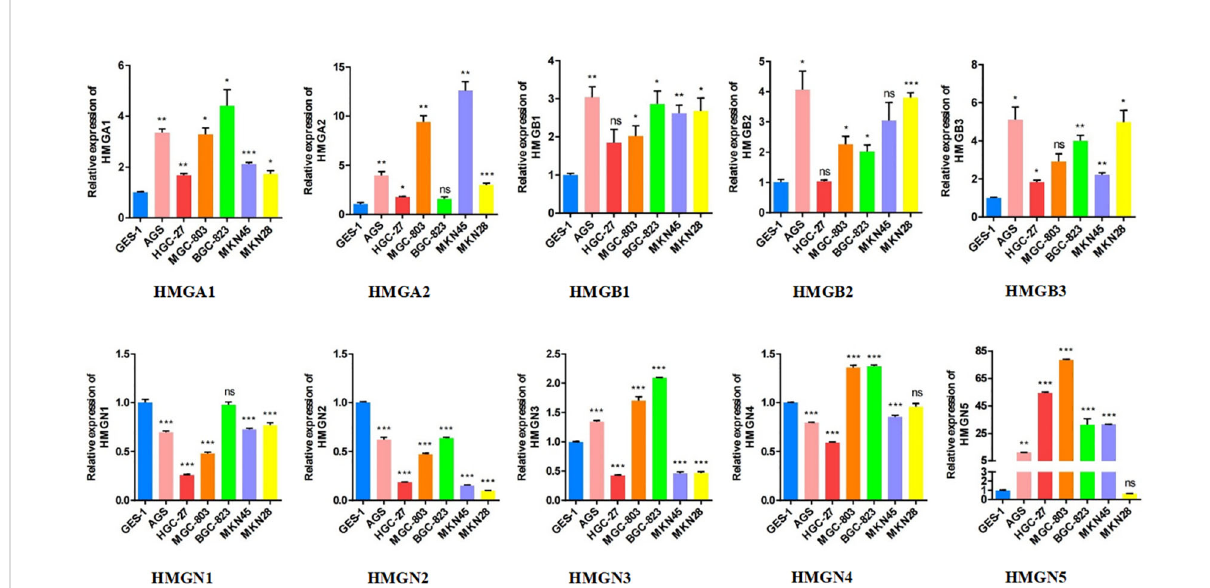
FIGURE 4 The relative expression levels of HMGs in GC cell lines (AGS, HGC-27, MGC-803, BGC-823, MKN-45, MKN-28) were detected by qRT-PCR (*p< 0.05; **p<0.01; ***p<0.001; NS, no statistically signi fi cant